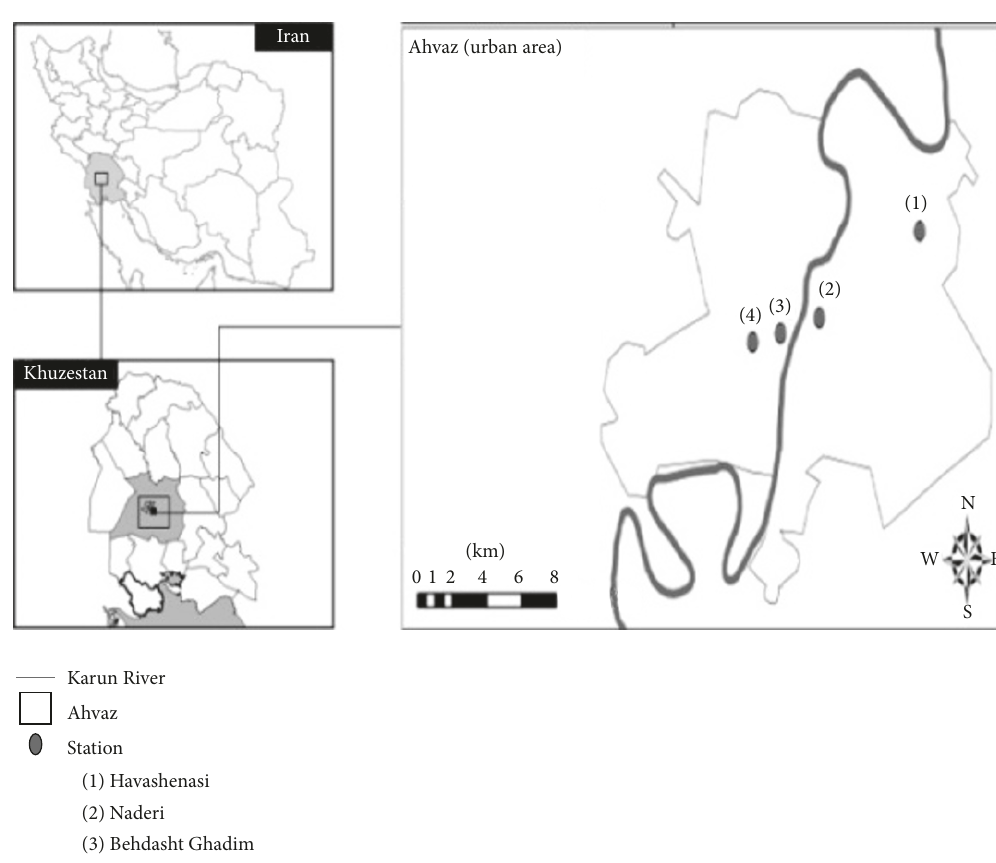
Figure 1: Air quality monitoring stations in